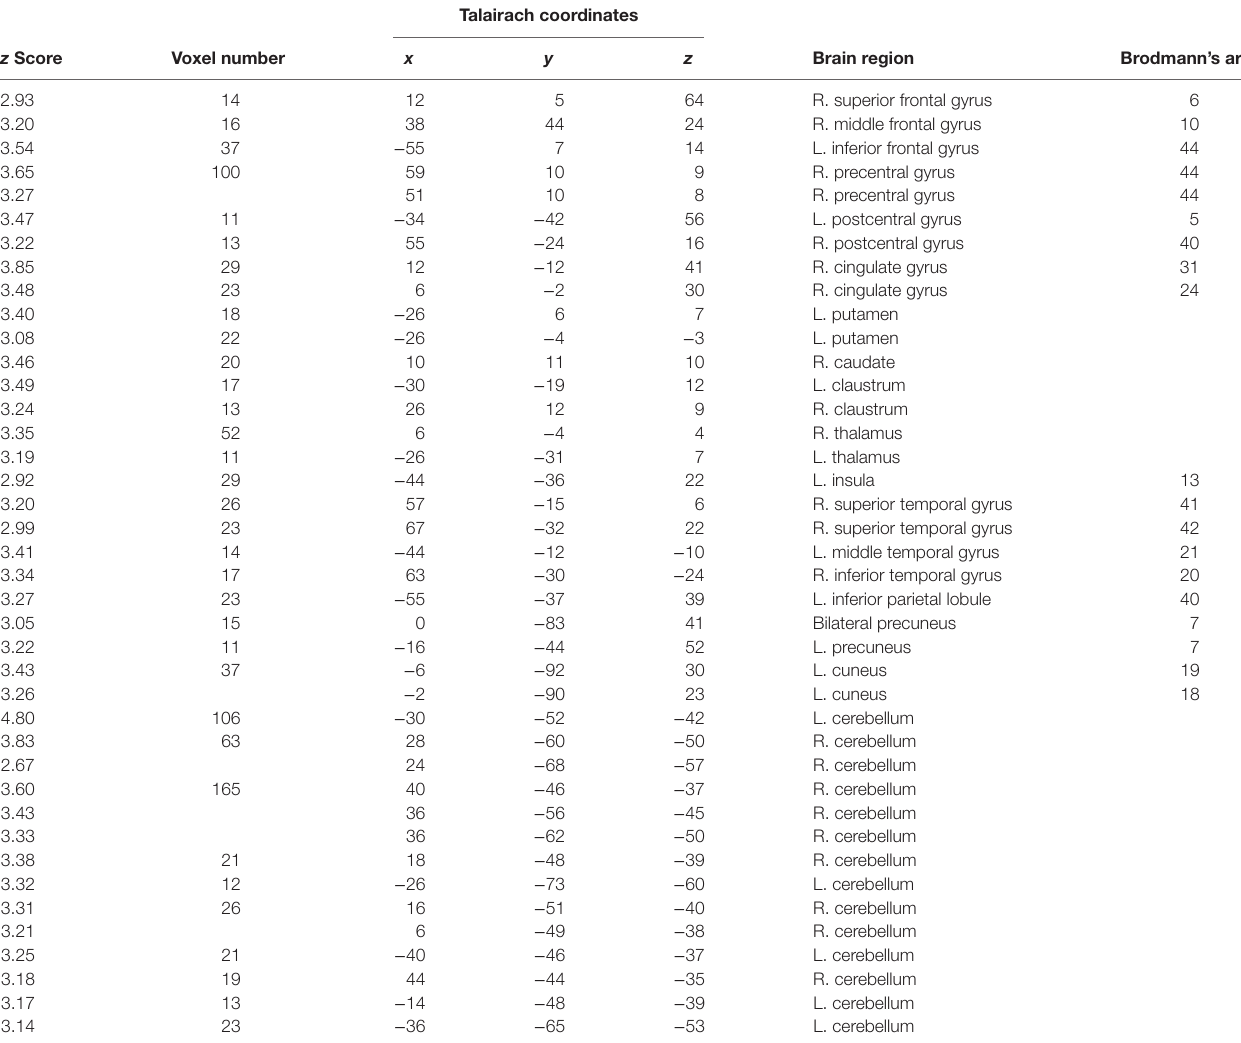
TaBle 4 | Areas of decreased activations for traumatic slide and sounds after present-centered group therapy